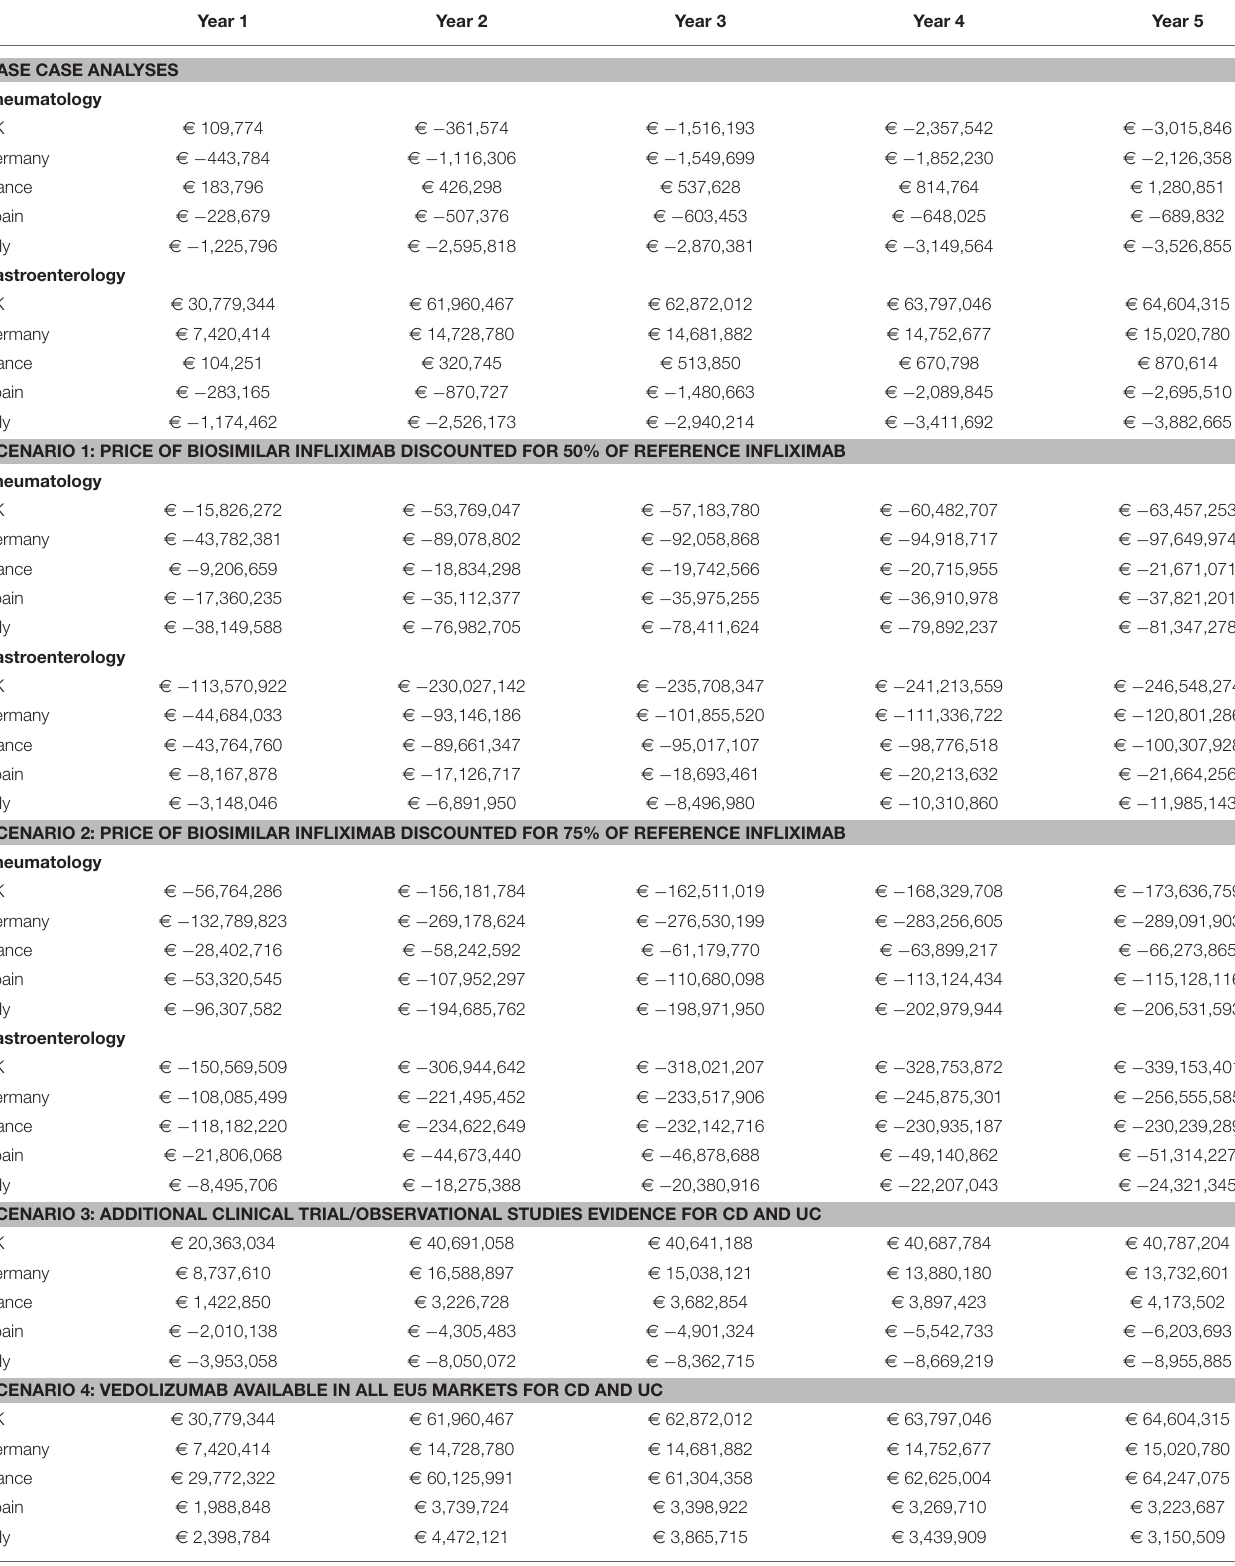
TABLE 4 | Budget impact of adopting biosimilar infliximab: scenario findings (including vedolizumab for Germany and United